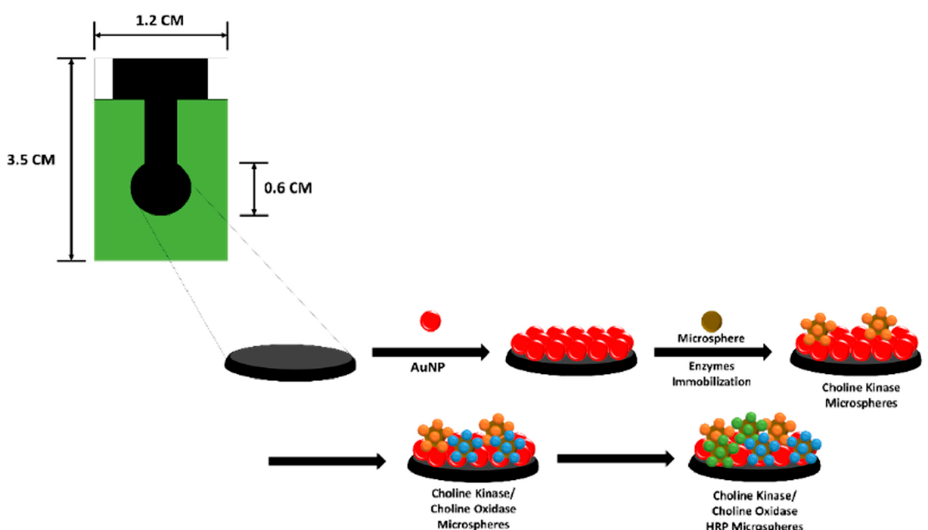
Figure 13. Schematic conception of a fabrication procedure for an amperometric biosensor to identify sPLA2-IIA as an indication of sepsis conditions. A tri-enzyme system consisting of choline kinase/choline oxidase/horseradish peroxidase was utilized to determine the target analytes by using cascading enzymatic reactions. These enzymes were immobilized onto acrylic microspheres functionalized with succinimide groups, which formed a composite with gold nanoparticles (AuNPs) to improve the electrode conductivity. The composite was deposited onto screen-printed electrodes (SPEs). Adapted from